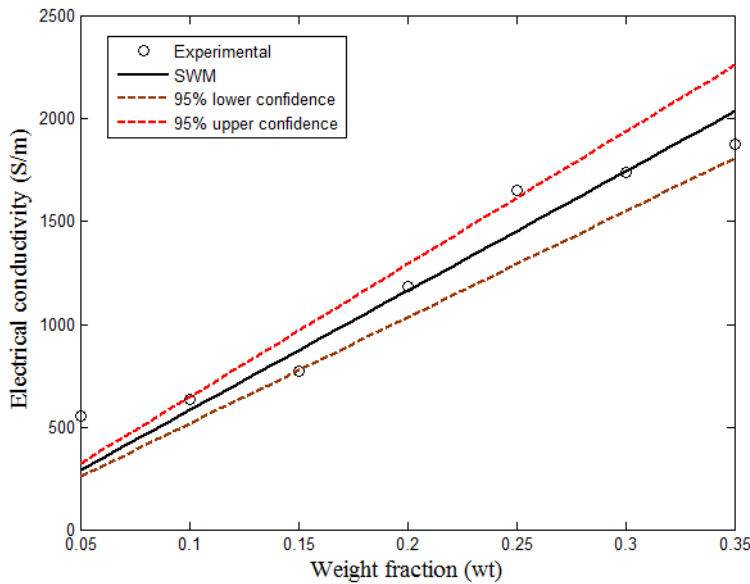
Figure 10. Comparison of experimental measurement with simplified Weber model (SWM).